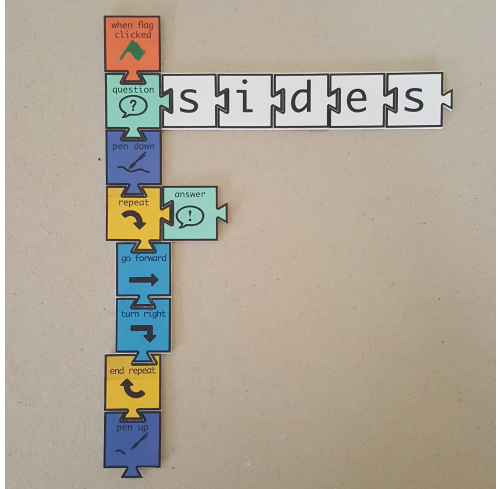
Figure 1. Tactode code example with 14 tiles that draws a regular polygon with the number of sides specified by the